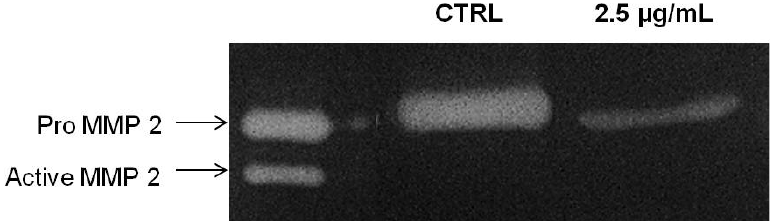
Figure 7. PA inhibited secretion of MMP-2 by A549 cells. Conditioned media of A549 cells treated with PA (2.5 µg/mL) for 24 h and vehicle control were subjected to gelatin